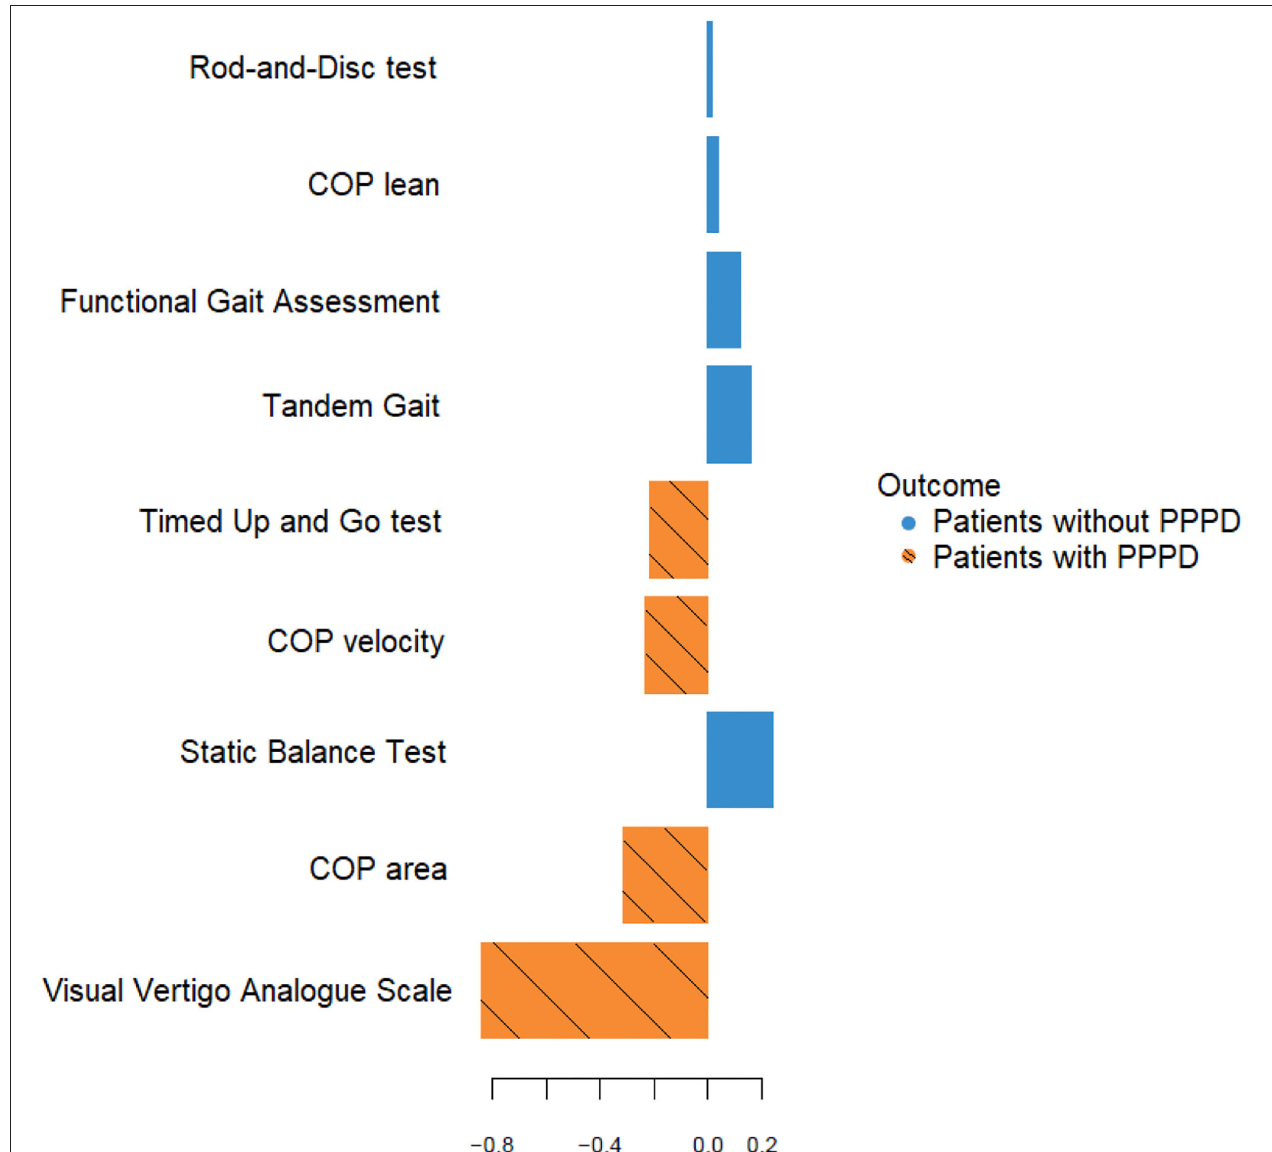
FIGURE 3 | Loading plot of the first component of the PLS-DA model a,b . a Loadings of the original variables for the first PLS-DA component are represented on the X-axis. The color of the horizontal bars shows in which of the two groups (patients with or without PPPD) the mean value of the original variable is the largest. In this dataset, the original variables with a negative loading on the first PLSDA component all have a larger mean value in the patients with PPPD. b COP, center of pressure; PPPD, persistent postural-perceptual